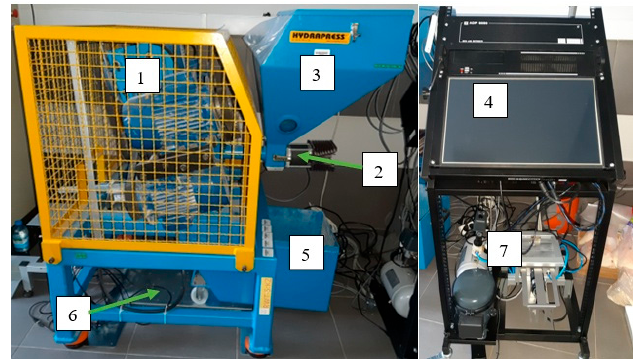
Figure 2. Test stand for monitoring the process of multi-disc grinding, 1—five-disc mill, 2—slide feeder, 3—hopper, 4—control panel, 5—product reception basket, 6—scales for the product, 7—chamber for measuring the size of the product after grinding.